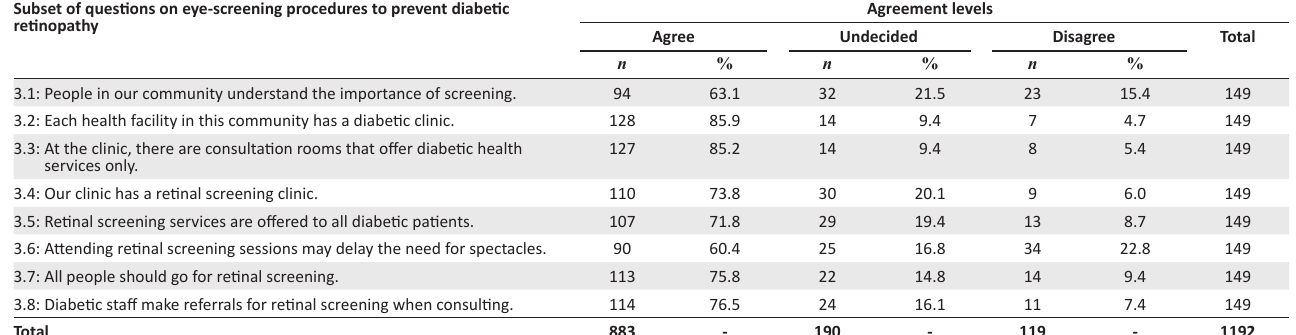
TABLE 3: Factors related to diabetic retinal screening.